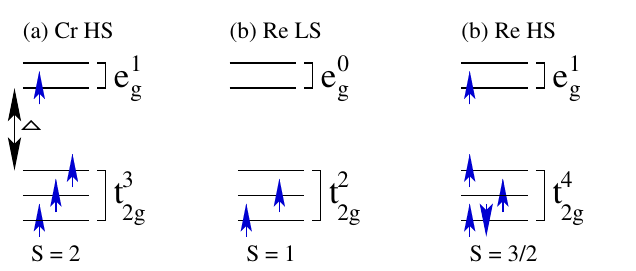
Figure 9. Schematic representation of ( a ) Cr high spin (HS), ( b ) Re low spin (LS), and Re intermediate spin (IS) states. (cid:31) represents the enegy gap between t 2 g and e g